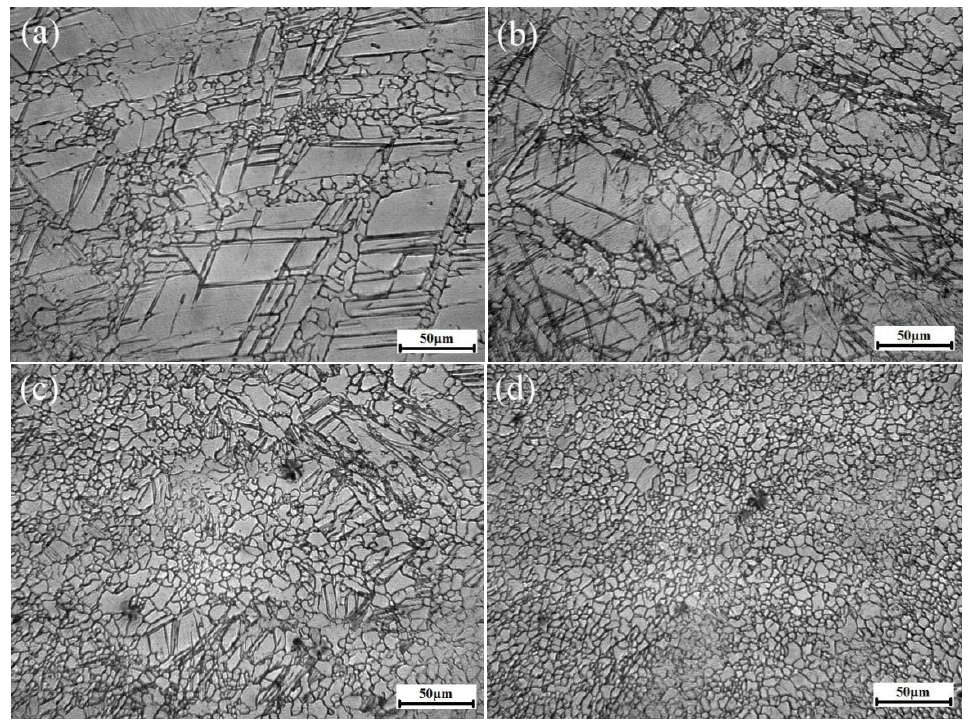
Figure 2. Microstructure of AZ31 alloys HSRMFed at 350 °C to different accumulated strains ( a ) 0.22, ( b ) 0.44, ( c ) 0.88, ( d ) 1.32.